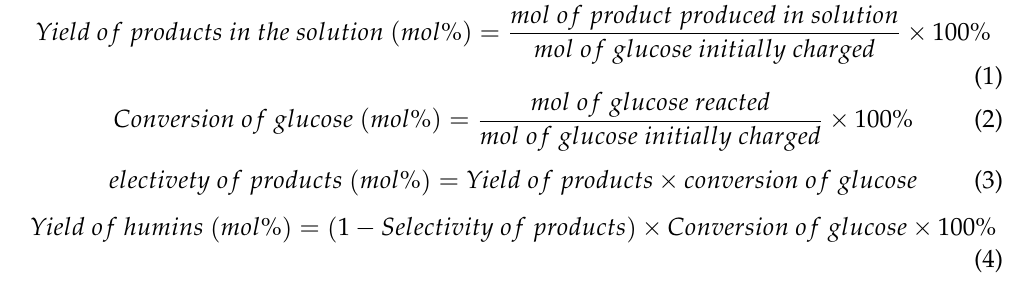
Table 1. The volume of solution in the vessel.